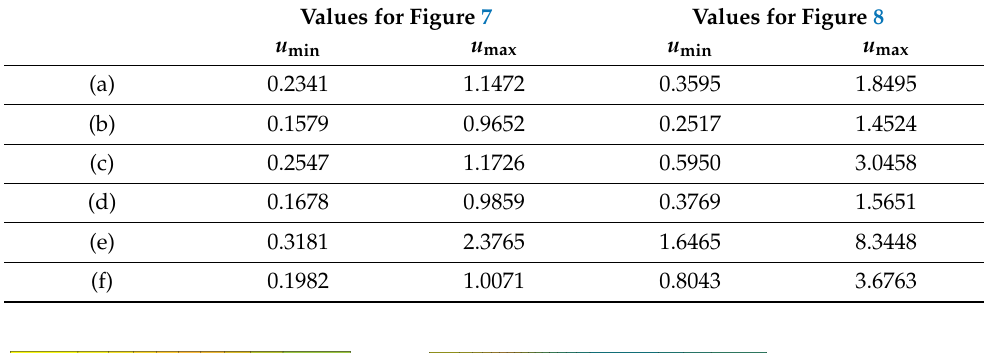
Table 7. Minimal and maximal values of the state u at T = 2 for Figures 7 and 8.